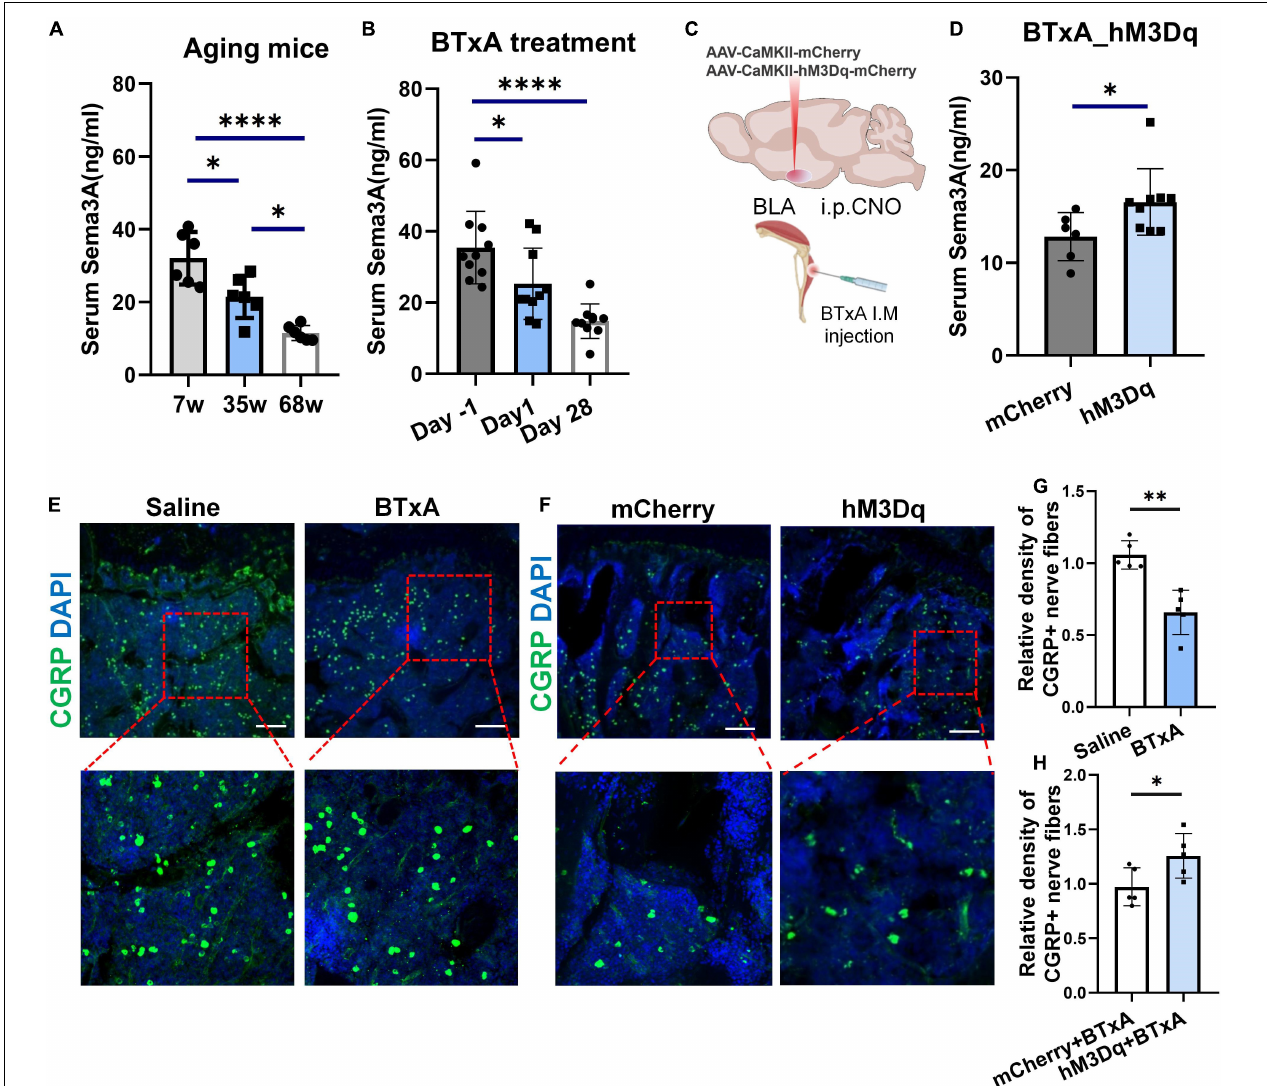
FIGURE 5 | Decreased Sema3A secretion with sensory nerve dysfunction in aging and muscle atrophic mice. (A) ELISA of serum Sema3A levels in mice at different ages, i.e., 7, 35, and 68 weeks old. (B) ELISA of serum Sema3A levels after BTxA-induced muscle dysfunction. (C) Chemogenetic activation of BLA CaMKII neurons after muscle paralysis. (D) ELISA of serum Sema3A levels in BTxA model after chemogenetic activation of BLA CaMKII neurons. (E) Representative immunofluorescent staining images of CGRP (green) in femurs of saline- or BTxA-treated mice. Scale bar, 50 µ m. (F) Representative immunofluorescent staining images of CGRP (green) in tibia after chemogenetic manipulation of BLA CaMKII neurons. Scale bar, 50 µ m. (G) Quantitative analysis of CGRP + -nerve fibers in BTxA-injected mouse models. (H) Quantitative analysis of CGRP + -nerve fibers in hM3Dq vs. mCherry group of BTxA-injected mice. All data represent mean ± SD. Statistical analysis was assessed using student t -tests for panel (D) and one-way ANOVA followed Tukey comparison test for panels (A,B) . ∗ P < 0.05, ∗∗ P < 0.01, ∗∗∗∗ P <